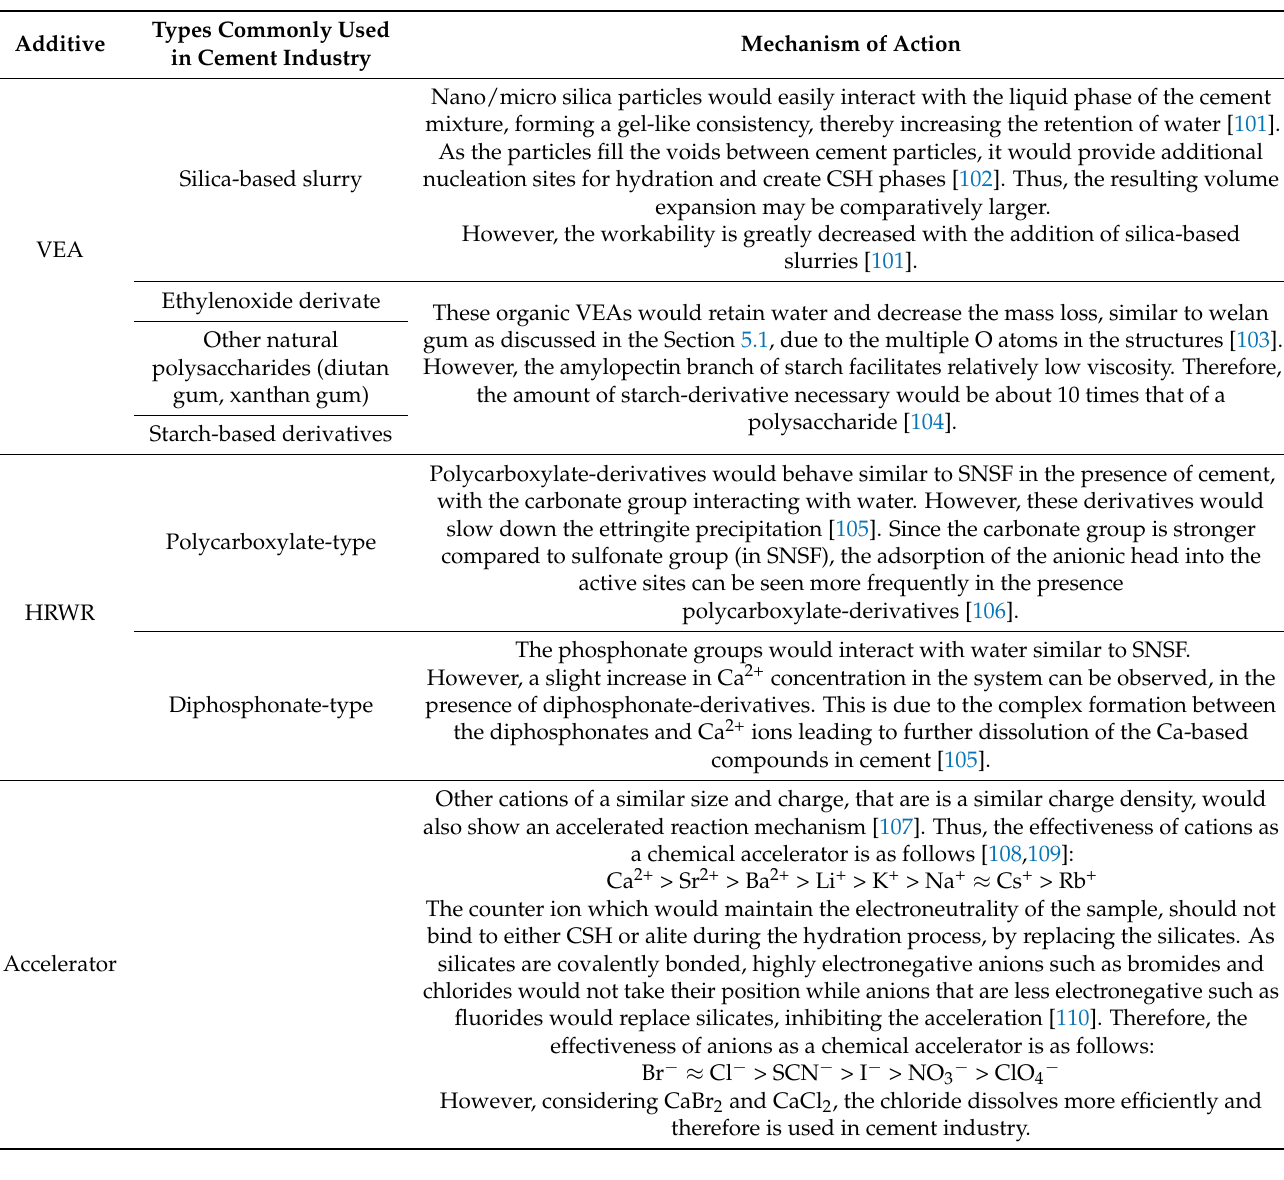
Table 3. Additives that can be considered for further development of